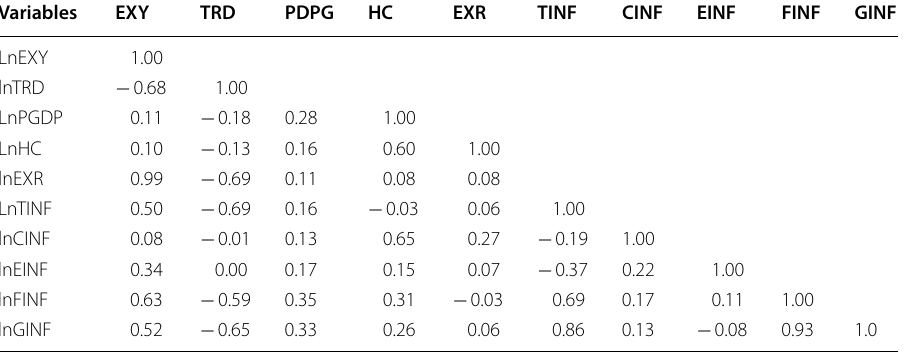
Table 11 Pearson correlation coefficients of the selected variables